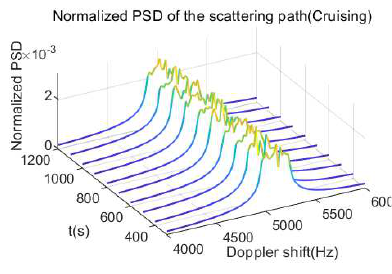
Figure 10. The normalized Doppler PSD (Cruising).